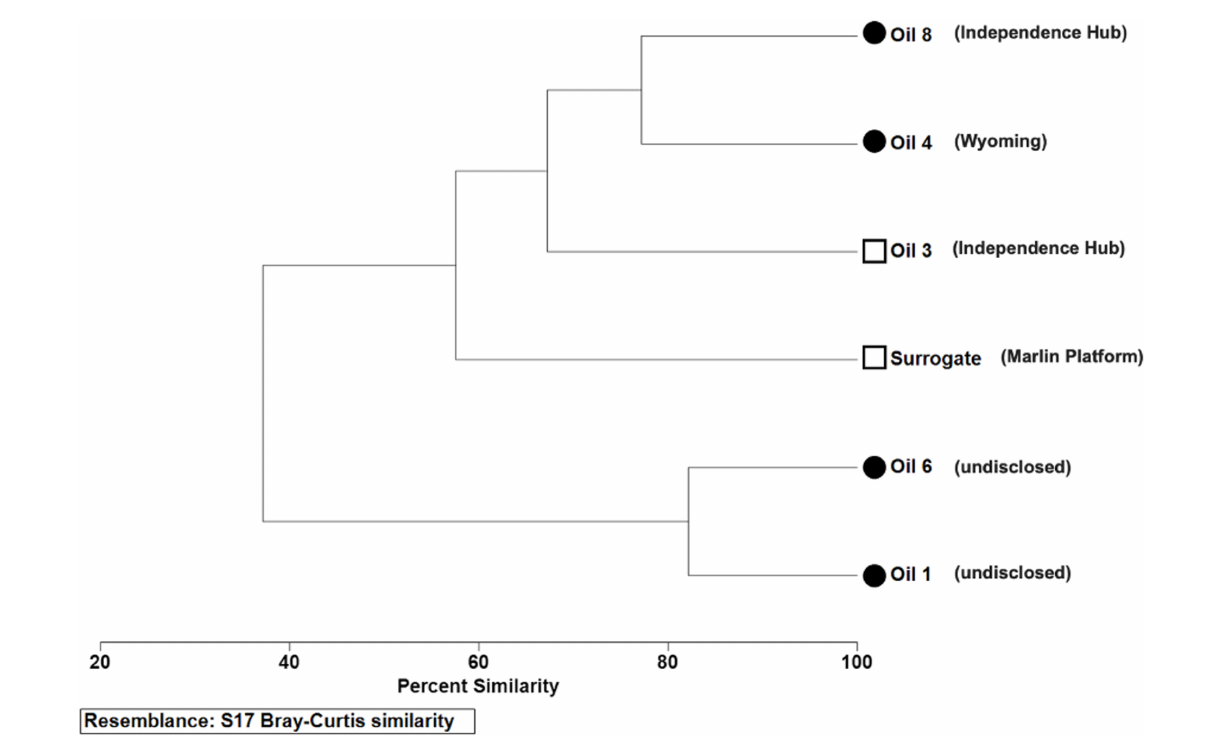
FIGURE1 Bray-Curtis similarity dendrogram with clustering based on oil chemical characteristics with scales standardized by min-max transformation. Characteristics include physical and chemical characteristics of crude oil samples as outlined in Table 1 , including sweetness, API gravity, and percent mass of C, N, H, and S. Sweetness ranges were defined as “sweet”, for oils with total sulfur < 0.5%; “sour”, with total sulfur > 0.5%. Circles, sour; Squares, sweet. Open symbols, light crude oils (API > 31.1); closed symbols, medium crude (API 22.3–31.1). Location of oils is indicated in parentheses, to the right of the oil name on the